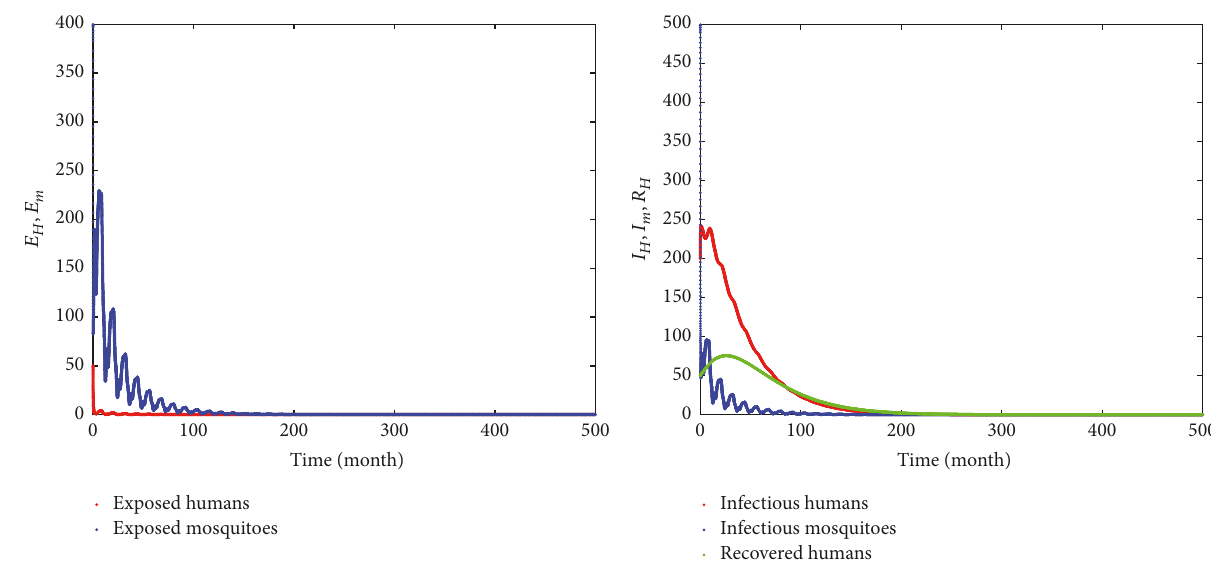
Figure 6: Distribution of infected humans and